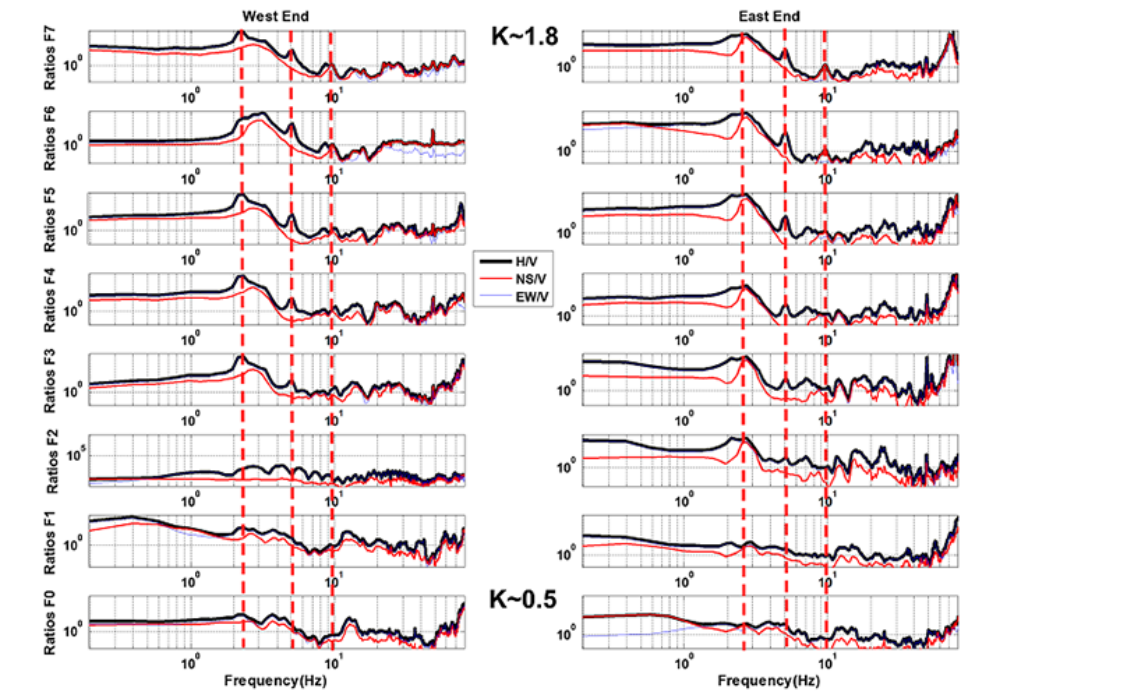
Figure 2. HVSR with black colour, N–S/V with red colour and E–W/V with blue colour on each floor for both sides (east and west) by Liu et al.(2014).